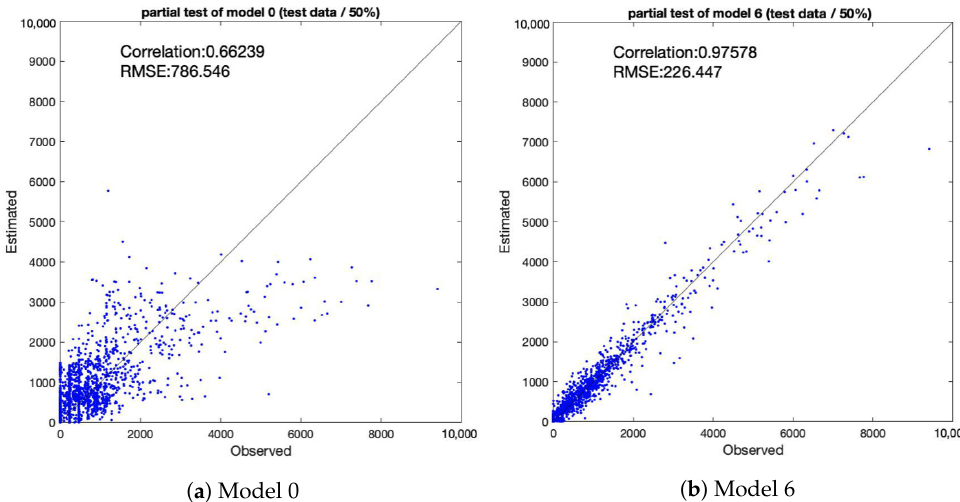
Figure 10. Correlation between observed and estimated population (after event